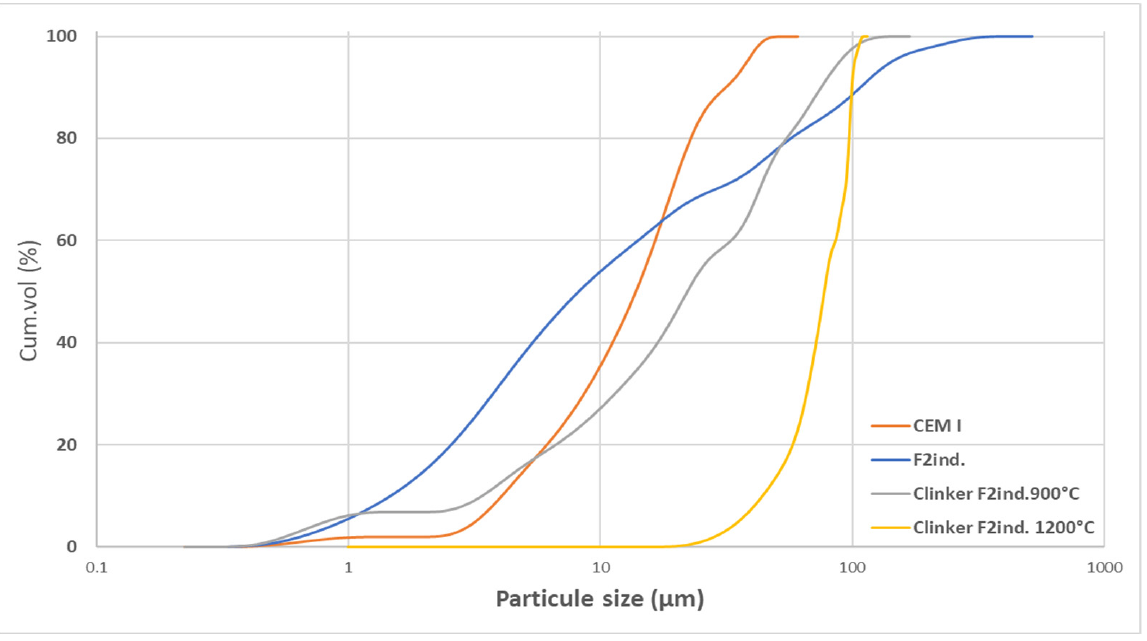
Figure 6. Particle size distribution of CEMI and clinker produced by indirect mechanosynthesis.